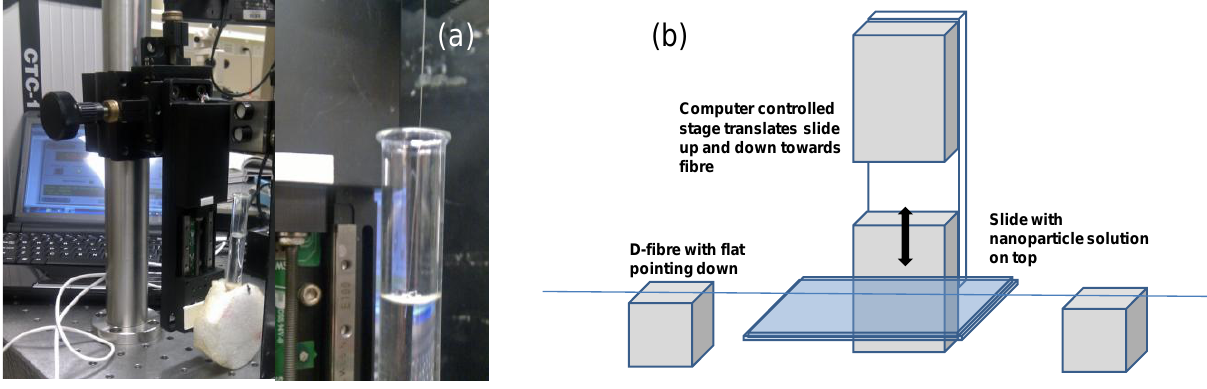
Figure 9. ( a ) Setup in use, with the miniature pump moving the solution onto the slide